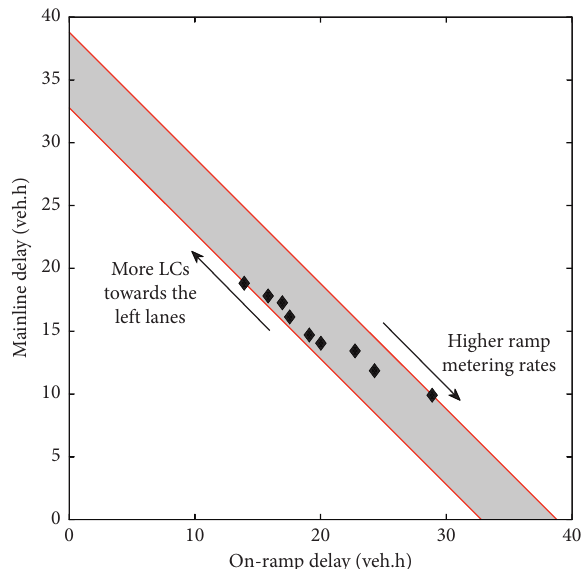
Figure 8: Variation of delays across the two streams with control